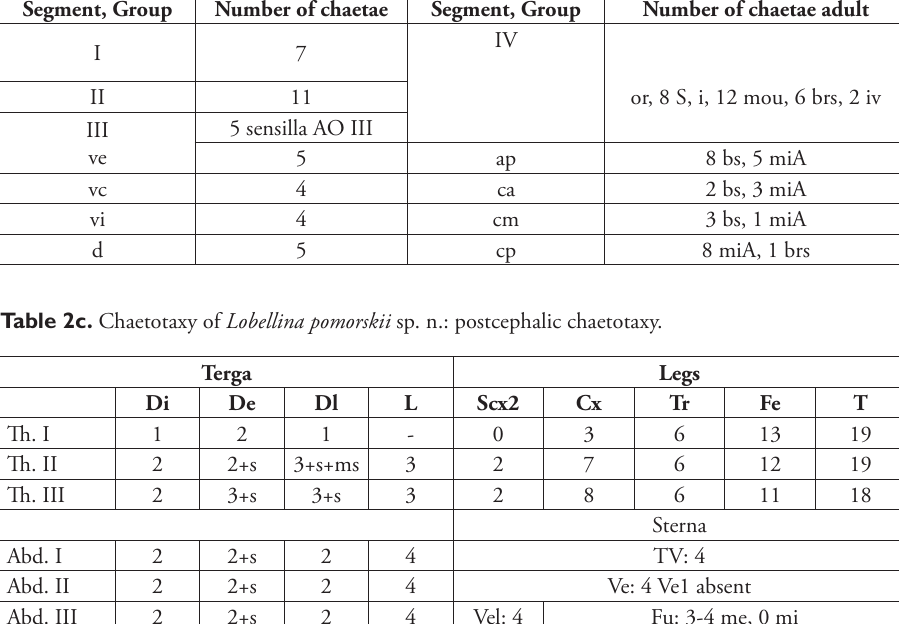
Table 2b. Chaetotaxy of Lobellina pomorskii sp. n.: chaetotaxy of antennae. Segment, Group Number of